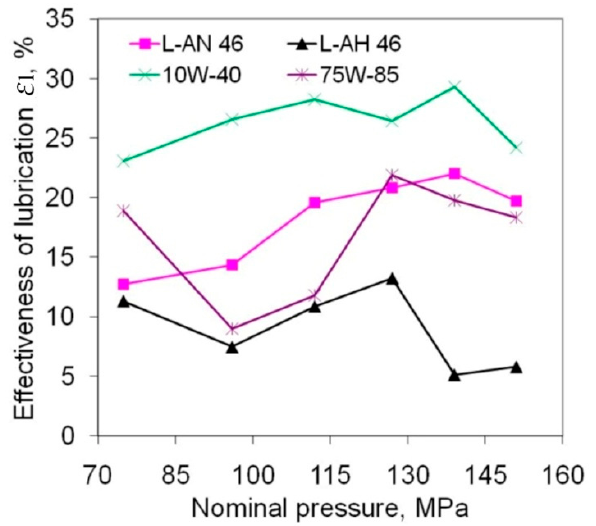
Figure 6. Effect of friction conditions on the effectiveness of